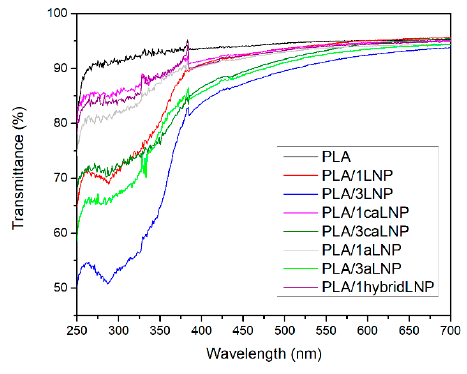
Figure 5. UV–Vis transmittance spectra of PLA and PLA nanocomposites films. Table 3. Transmittance (%) at 320 nm of PLA and PLA nanocomposite films.